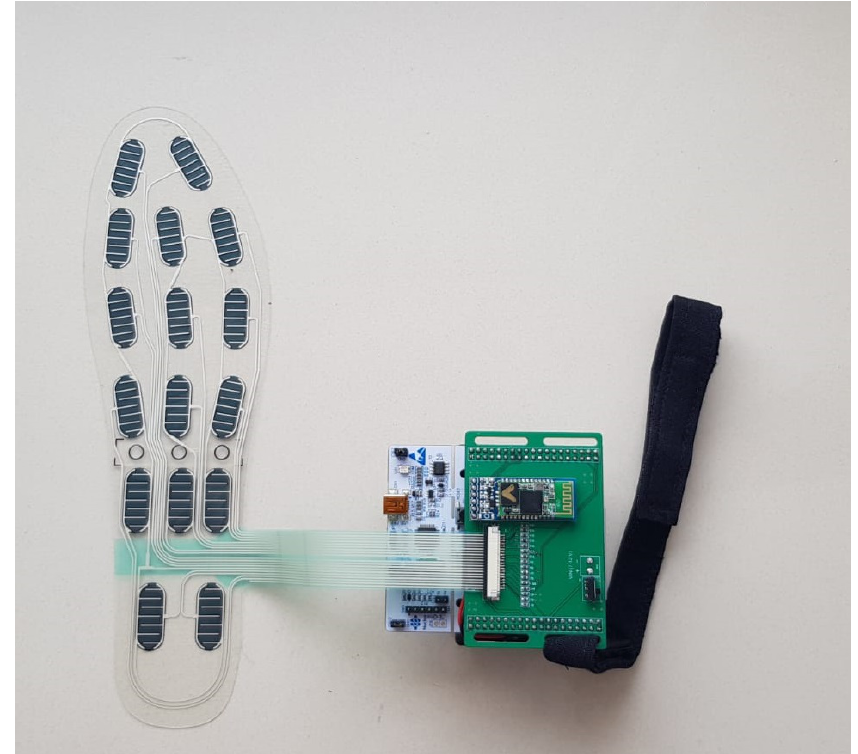
Figure 12. Full hardware presentation.